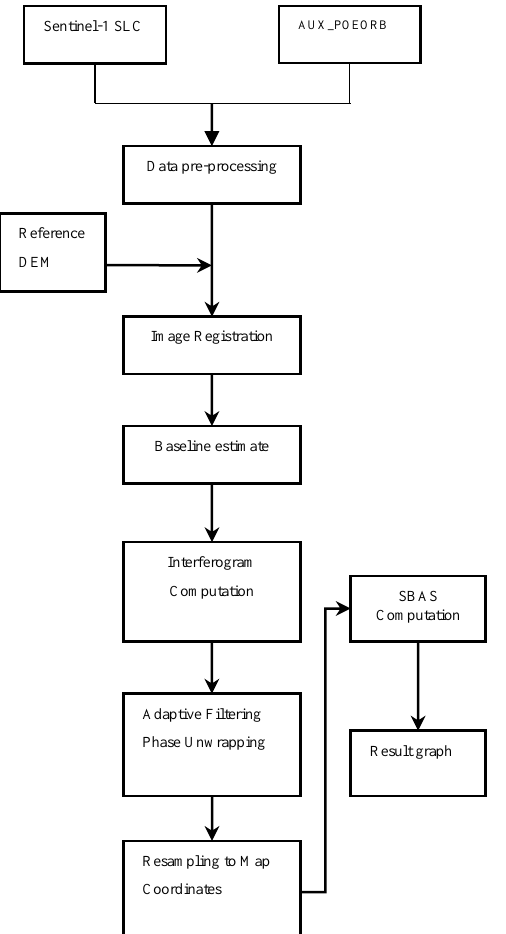
Figure 2. Flowchart of SBAS algorithm based on TOPS SAR